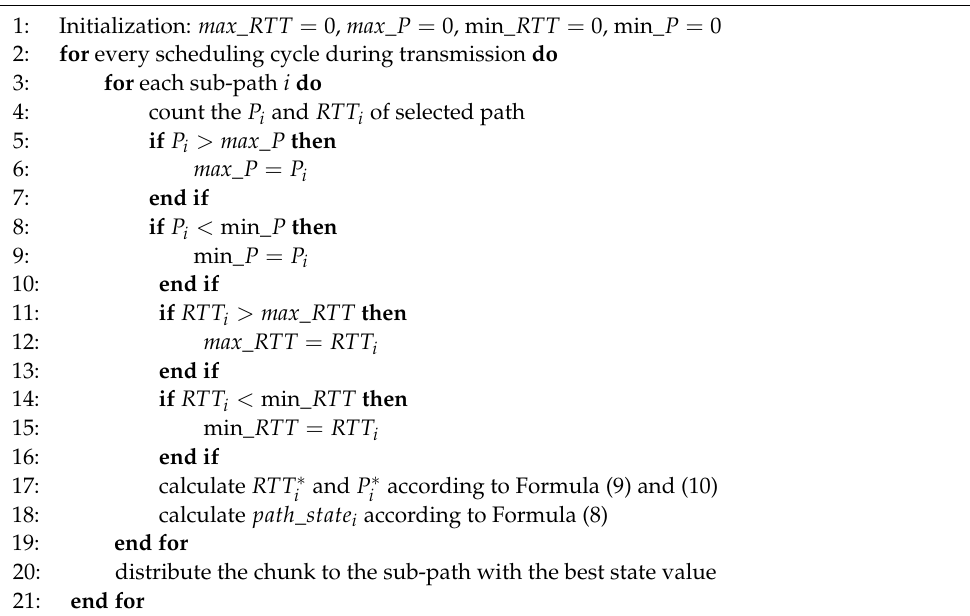
Algorithm 2 Data-Scheduling